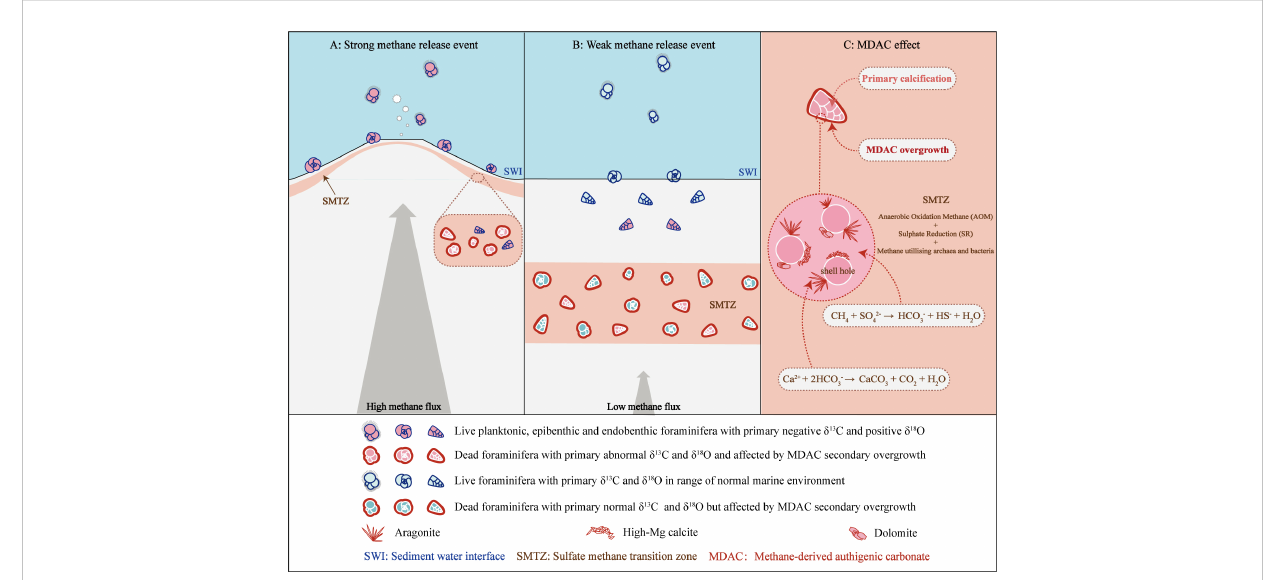
FIGURE 5 Impact on foraminifera stable isotopic signatures from methane seepage intensity and the MDAC-covered coating. (A) Impact during high methane fl ux period. (B) Impact during low methane fl ux period. (C) Zoom schematic of the MDAC-covered coating on foraminifera